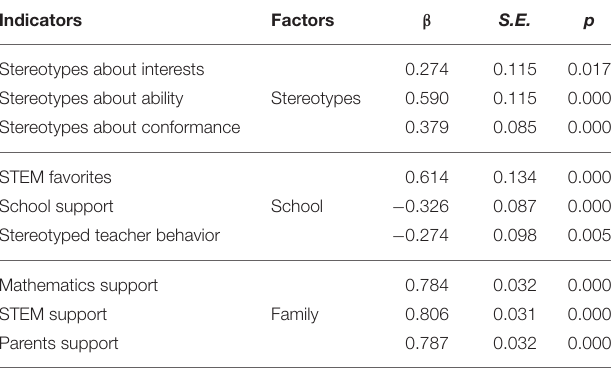
TABLE 3 | Standardized coefficients for the latent regression